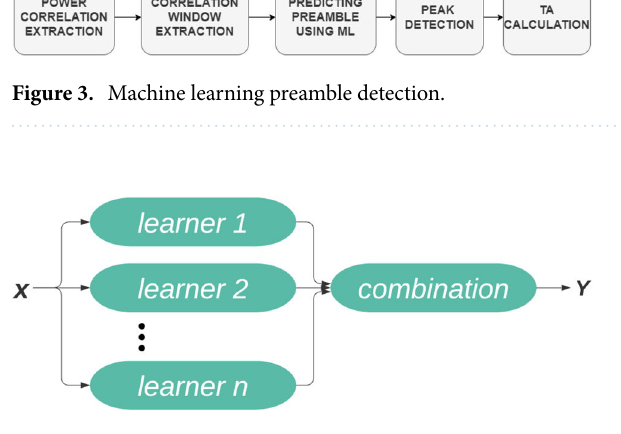
Figure 4. Architecture of ensemble.